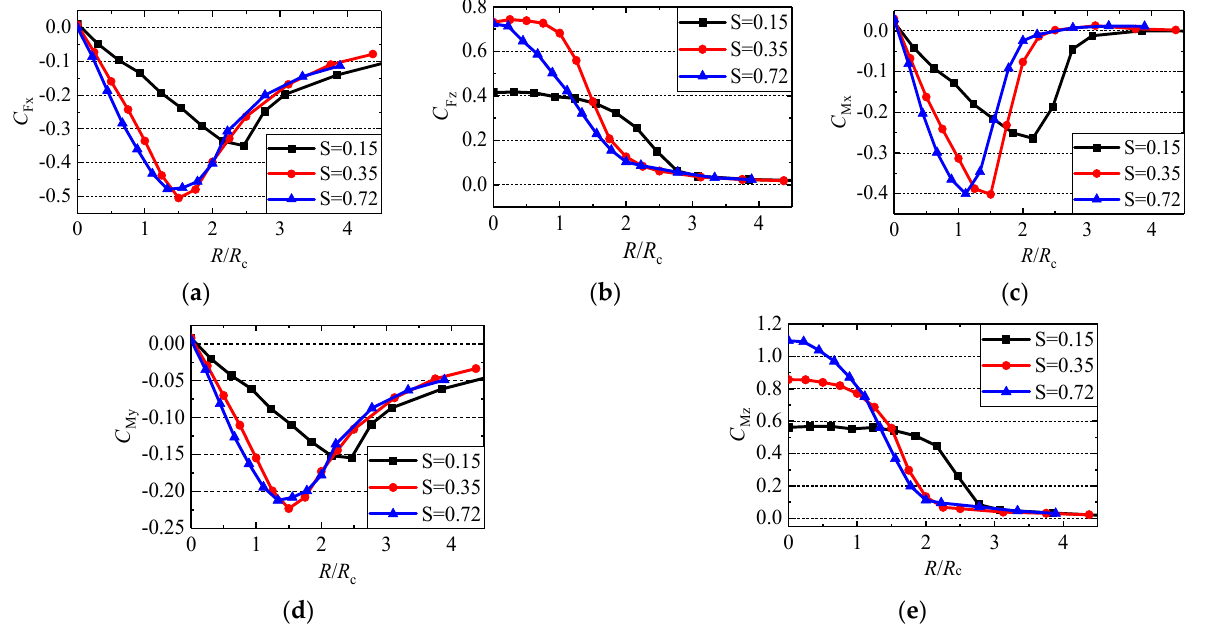
Figure 19. Variations in the wind force coefficients with R/Rc under different swirl ratios ( λ = 0). ( a ) C FX ; ( b ) C FZ ; ( c ) C MX ; ( d ) C MY ; ( e ) C MZ .